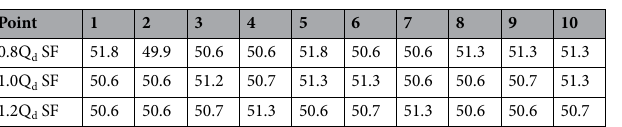
Table 8. Test shaft frequency of each measuring point (unit: